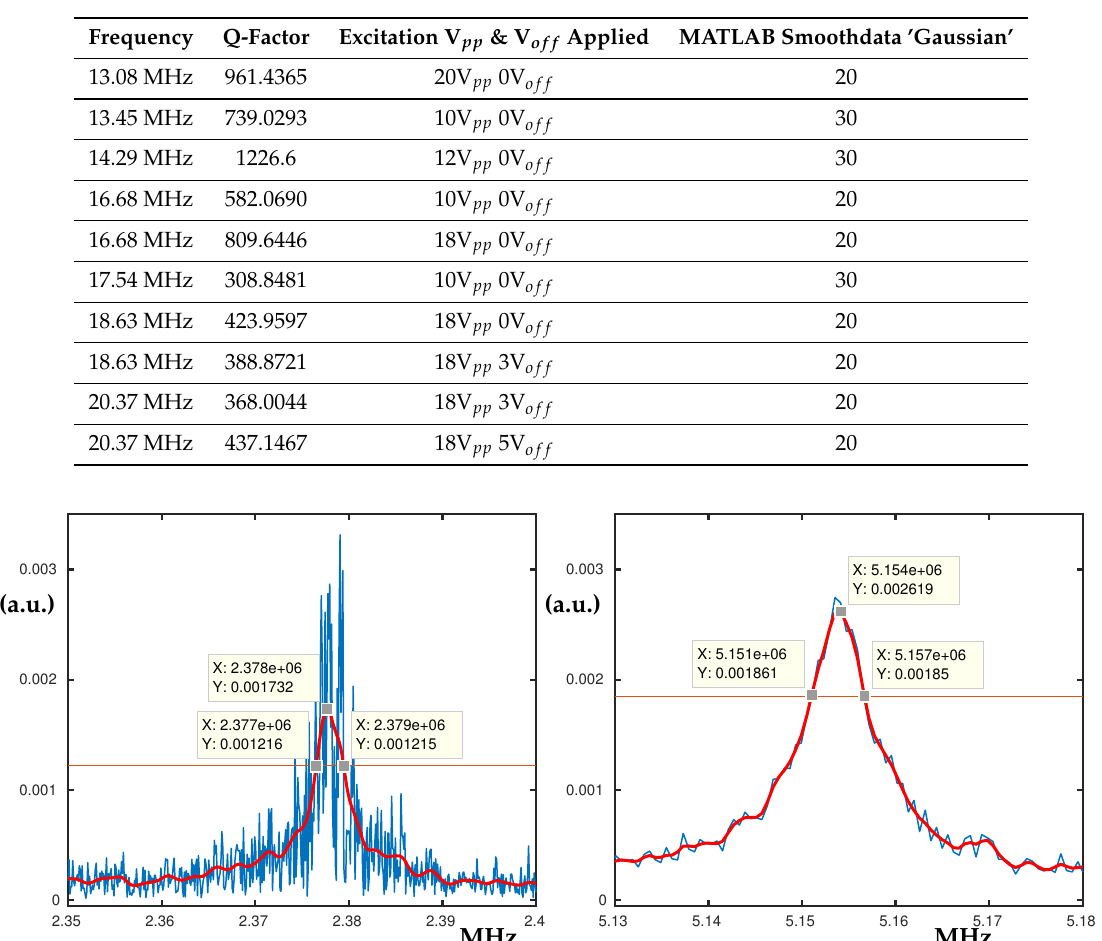
Figure A10. Matlab approximation by ’smoothdata’ function with Gaussian filter followed by Q-factor derivation that result in 806 and 912 for the 2.378 MHz and 5.154 MHz peaks respectively.